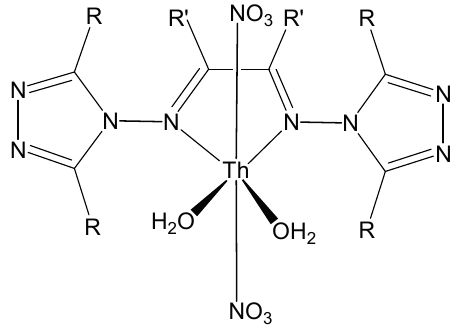
Figure 21. Proposed structure of thorium Schiff-base